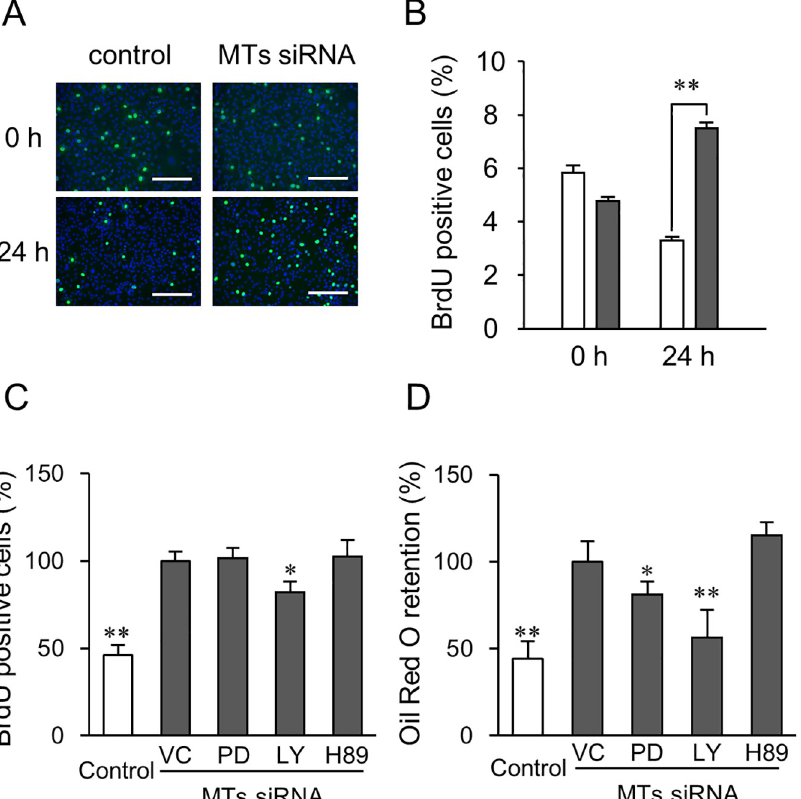
Fig 6. Effect of MTs siRNA on BrdU incorporation during post-confluent mitosis, known as mitosis clonal expansion. After siRNA pretreatment for 24 h, 3T3-L1 preadipocytes were stimulatedwith DIM for 0 or 24 h followedby exposureto 10 μ M BrdU for 2 h. (A) The BrdU incorporated into replicatingDNA was detected using an anti-BrdU primary antibody and fluorescein-conjugatedsecondary antibody using a fluorescence microscope (green). All nucleiwere counterstained with Hoechest 33258 (blue). Bar = 200 μ m. (B) The number of BrdU-positive cells is expressedas a percentage of Hoechst-stained nuclei. (C) and (D) After siRNA pretreatment for 24 h, 3T3-L1 preadipocytes were not treated (VC, vehiclecontrol (DMSO)), or were treated with the indicatedinhibitors (50 μ M PD98059(PD), 50 μ M LY294002(LY), or H89) for 30 min. (C) After treatment, the cells were stimulatedwith DIM for 24 h. The numberof BrdU-positive cells is expressedas a percentageof the number of MTs siRNA-treated cells without inhibitortreatment. (D) After treatment, 3T3-L1 preadipocytes were inducedto differentiatefor eight days, as describedin the Materials and Methods section. Natural lipids in the fixed cells were stainedwith Oil Red O. The absorbance of Oil Red O was measured, and Oil Red O retention is expressedas a percentage of the number of MTs siRNA-treated cells without inhibitortreatment. (B), (C), and (D) Open columns are control RNA-pretreated cells, and closed columns are MTs siRNA-pretreatedcells. Data are expressedas the mean ± SD (B and C, n = 3; D, n = 5). (B) ** P < 0.01. (C) and (D) * P < 0.05 and ** P < 0.01, comparedto MTs siRNA-treated cells without inhibitor